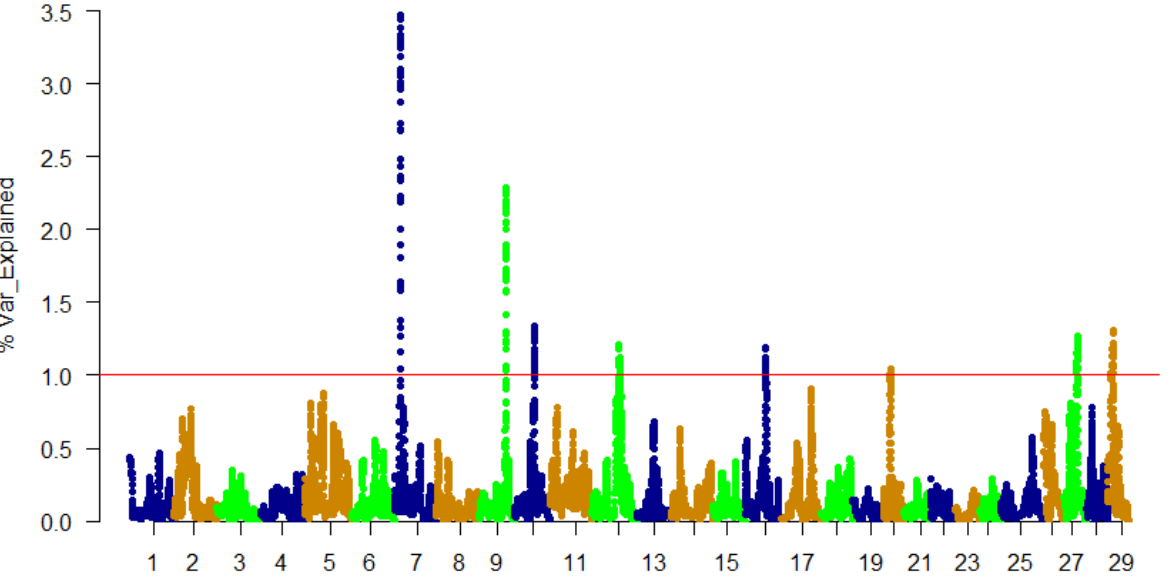
Figure 1. Manhattan plot of percent of genetic variance explained by 50 adjacent SNP windows for fillet redness (a*).